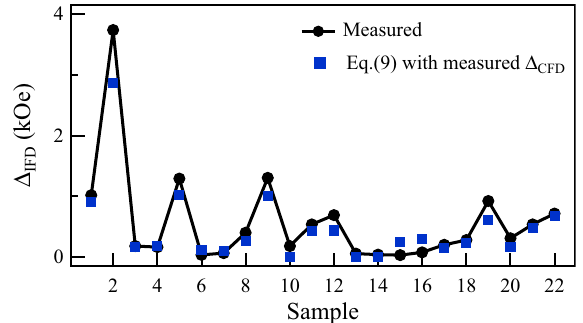
Figure 6. Interaction field distribution width, (cid:31) IFD , measured from the FORC diagrams (line with circles) compared with the width calculated with Eq. (9) using the measured values of (cid:31) CFD and H c